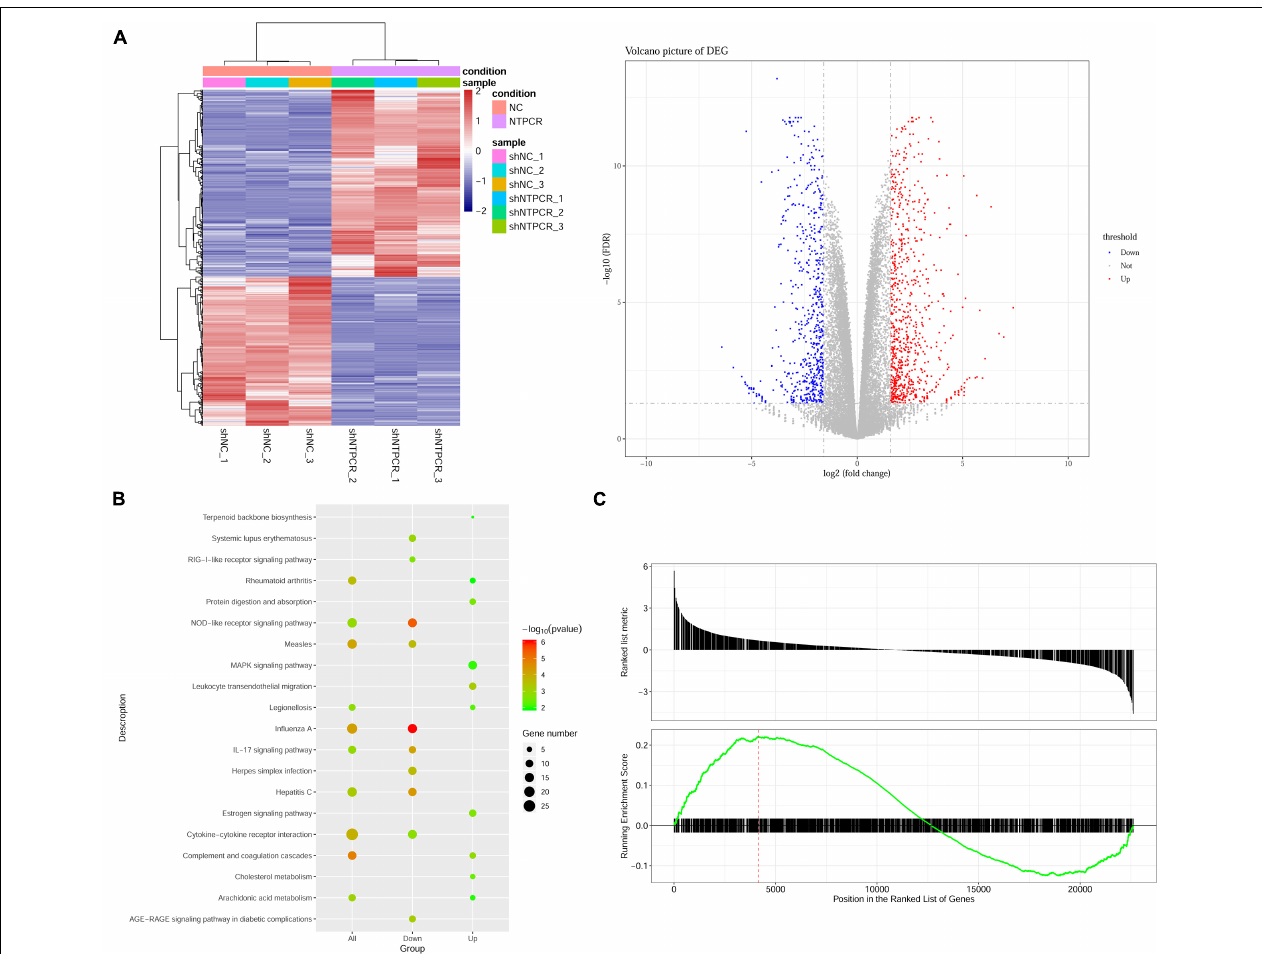
FIGURE 3 | Identification of DEGs between shNTPCR ovarian cancer groups and control shNC groups. (A) Two-dimensional clustering analysis (left) and volcano plot (right) for DEGs. Columns in the clustering analysis results represent different samples, while rows refer to differential genes; red and blue color represent upregulated and downregulated expression. Dots in the volcano plot diagram represent differential genes. Red and blue dots refer to upregulated and downregulated genes. (B) KEGG pathway enrichment analysis results for DEGs. The pathway with a smaller p -value represented a significant enrichment degree. The dot sizes refer to the count number of genes enriched by the pathway category. (C) GSEA results of dysregulated genes in ovarian